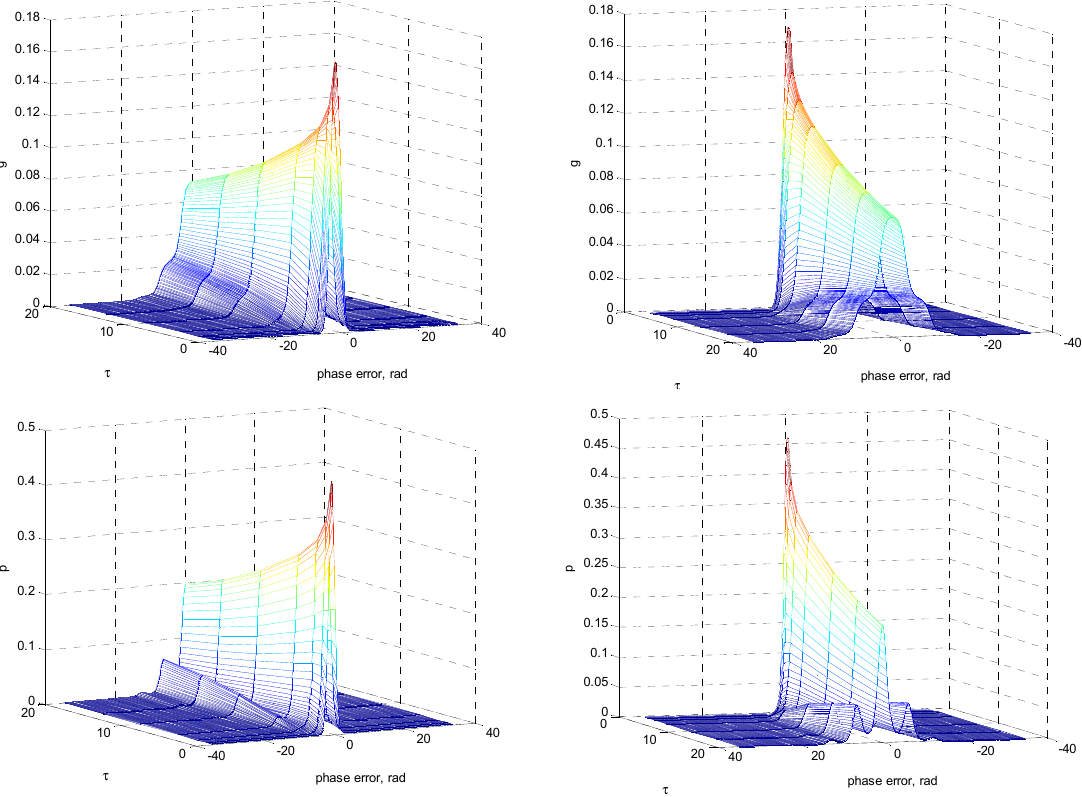
Figure 4. Three-dimensional plots for nonmodulo-2 π transition g and p , respectively, for SNR α = 1 as time progresses: front view ( left ) and back view ( right ) ( γ = 0 ).